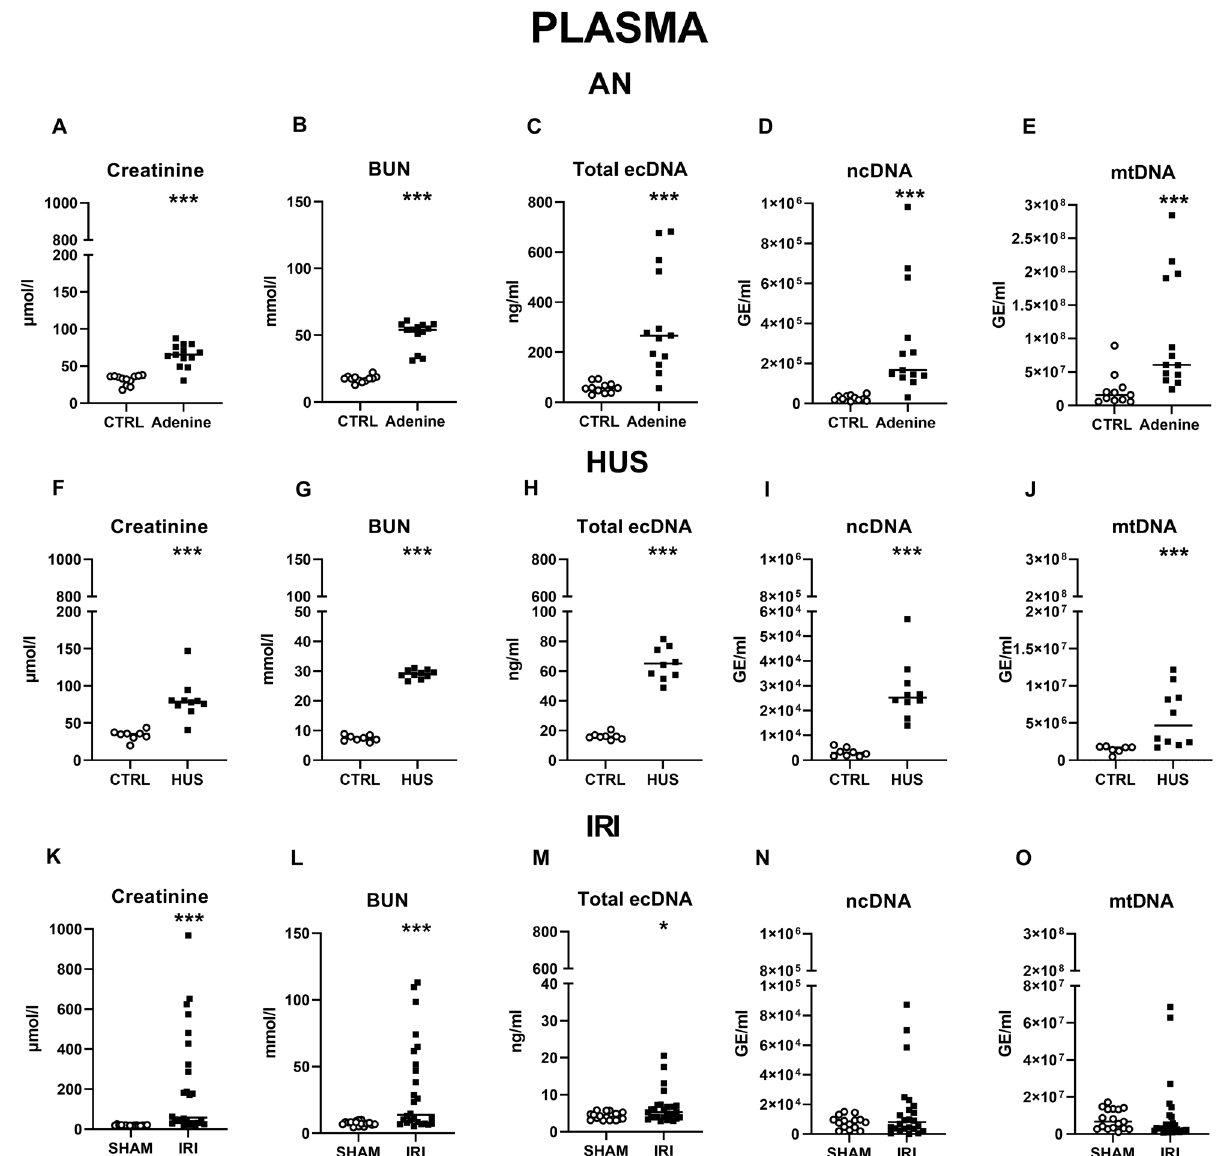
Figure 2. Kidney functions, concentrations plasma ecDNA and its subtypes in different animal models of AKI. Plasma ( A ) creatinine, ( B ) BUN, ( C ) total ecDNA, ( D ) ncDNA, ( E ) mtDNA in mice with AN and control animals. Plasma ( F ) creatinine, ( G ) BUN, ( H ) total ecDNA, ( I ) ncDNA, ( J ) mtDNA in mice with HUS and healthy controls. Plasma ( K ) creatinine, ( L ) BUN, ( M ) total ecDNA, ( N ) ncDNA, ( O ) mtDNA in IRI rats and sham animals. Results are presented by individual values plots with median. * denotes p ˂ 0.05, *** denotes p ˂ 0.001 in comparison to healthy controls or sham animals, respectively. AN adenine nephropathy, BUN blood urea nitrogen, ecDNA extracellular DNA, HUS haemolytic uremic syndrome, IRI ischemia–reperfusion injury, mtDNA mitochondrial DNA, ncDNA nuclear